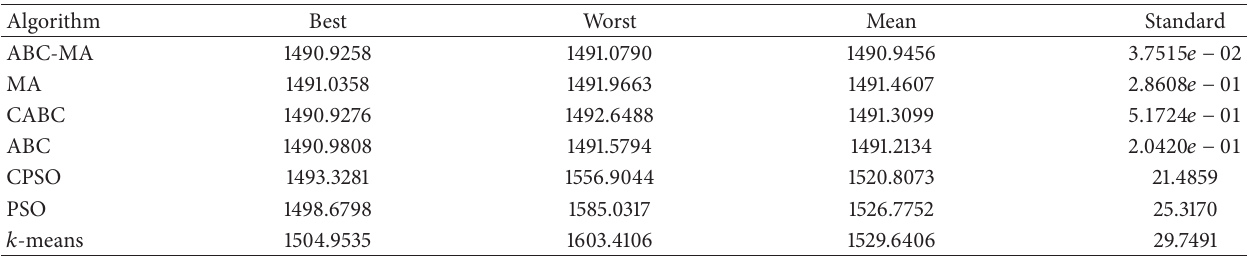
Table 4: Results obtained by the algorithms for 20 different runs on TAE data.